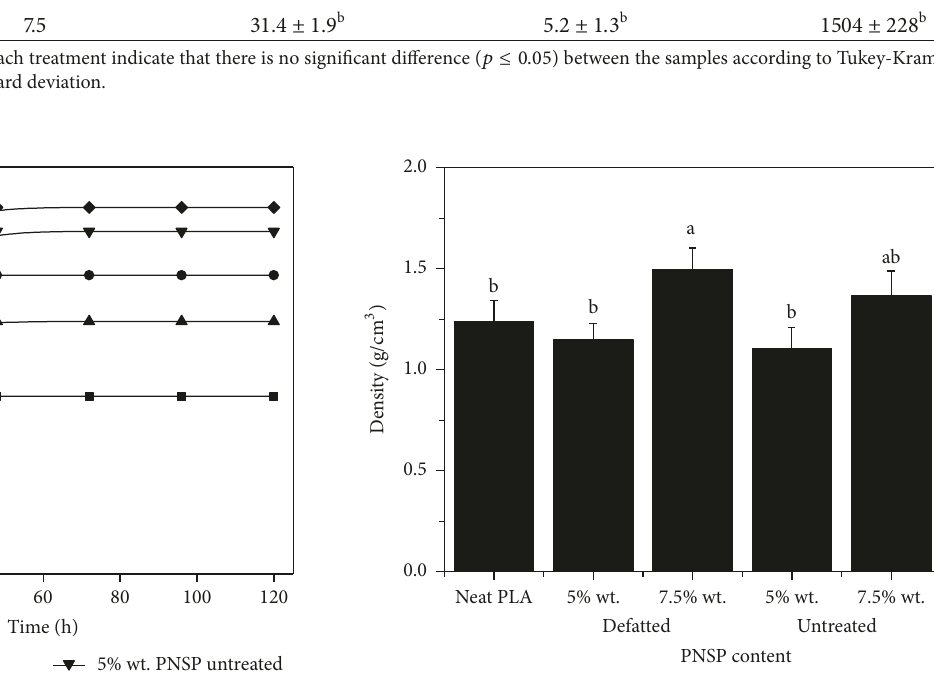
Figure 3: Density values of neat PLA and PLA-PNSP biocompos-